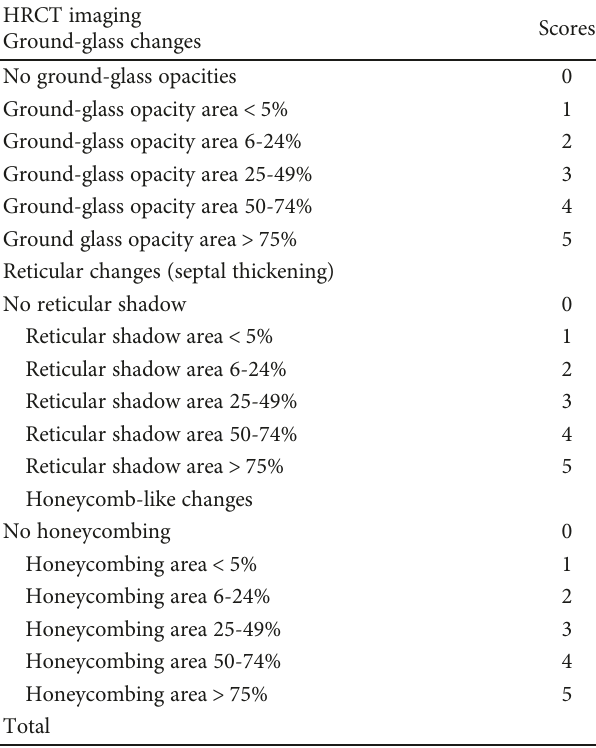
Table 1: HRCT scoring